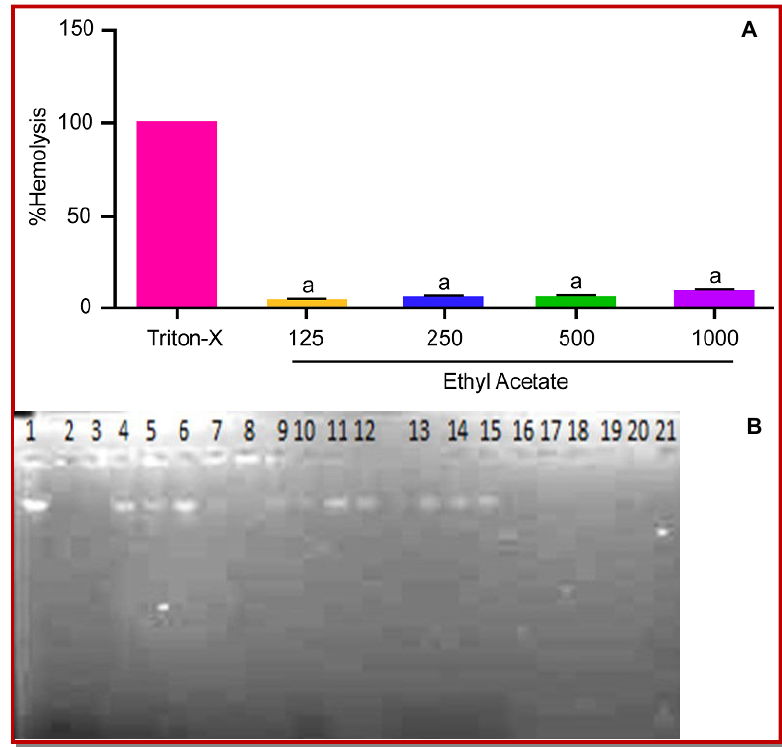
Figure 1: Effect of ethyl acetate extract of M. orontium on %hemolysis ( a p<0.001) (A); on DNA damage protection activity (B). Lane 1 : 4 µL DNA + 16 µL DW, Lane 2 : 3 µL FR + 17 µL DW, Lane 3 : 4 µL DNA + 3 µL FR + 13 µL DW, Lane 4 : 4 µL DNA + 4